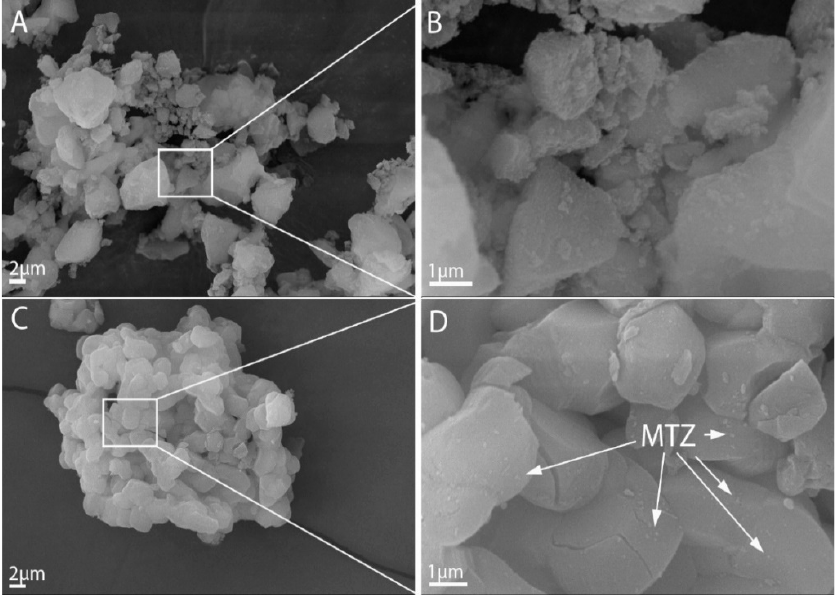
Figure 5. SEM images of the Syloid and SBA-15 ( A , C ) carriers and metronidazole immobilized on their surface ( B , D ).